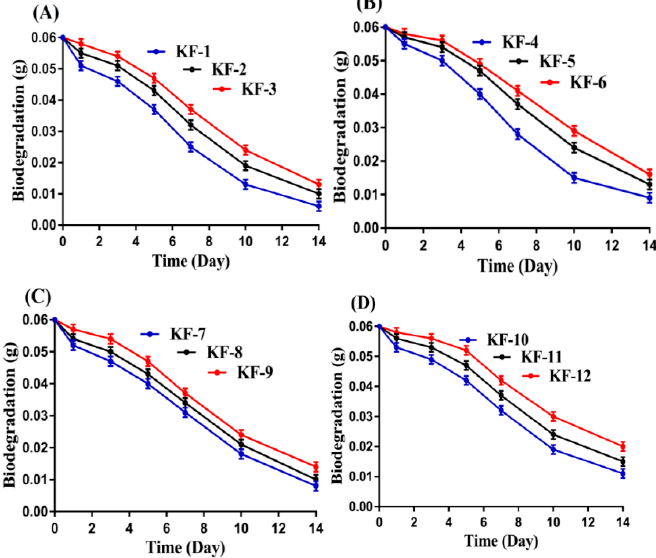
Figure 9. Effect of ( A ) CS (KF-1-3), ( B ) CP (KF-4-6), ( C ) PVA (KF-7-9), and ( D ) Aa (KF-10-12) on biodegradation of CS/CP/PVAcPAa hydrogel.